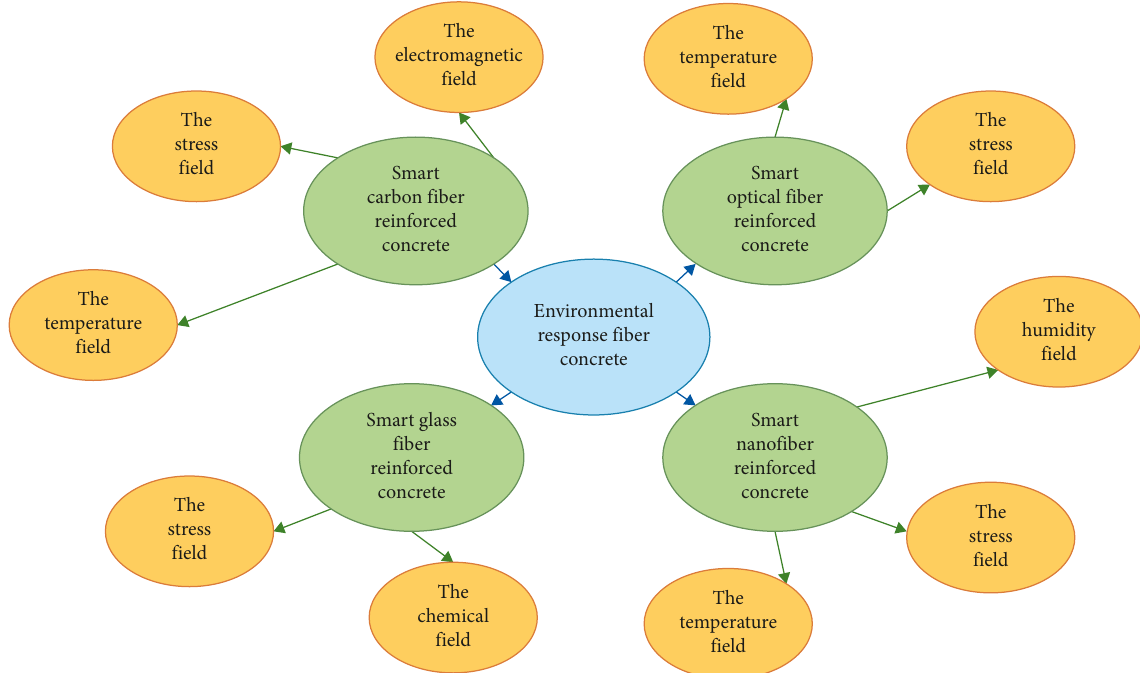
Figure 1: Types of FRC and their environmental response